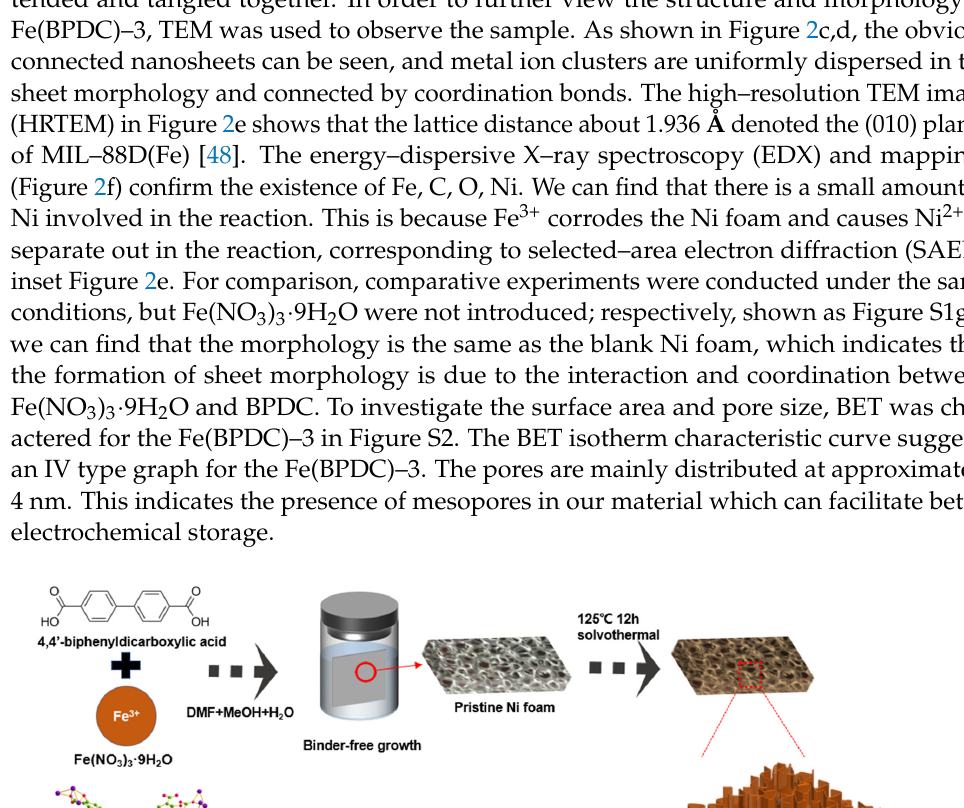
( f ) Elemental mapping results of Ni, Fe, C, and O, respectively. (Inset: FFT patterns of the selected